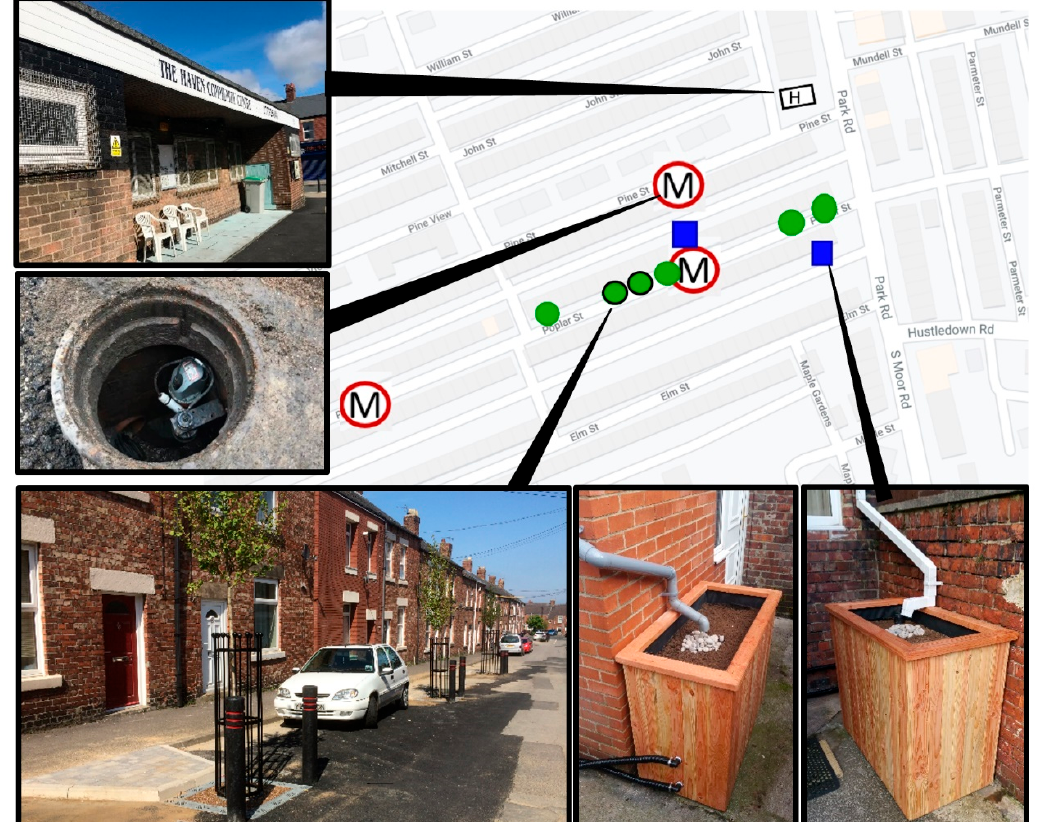
Figure 3. The location of three monitoring points (M), two rear yard planters (blue squares), four street trees (green circles) and two sustainable drainage systems (SuDS) tree pits (green circle with black edge) on Pine Street and Poplar Street (not to scale). The dashboard interface was installed in The Haven Community Centre (H).